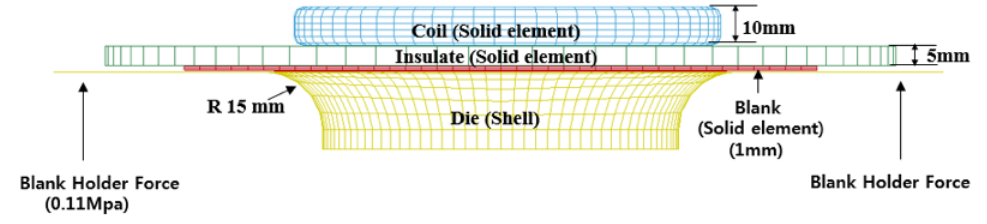
Figure 6. Computational models for a free bulge test with